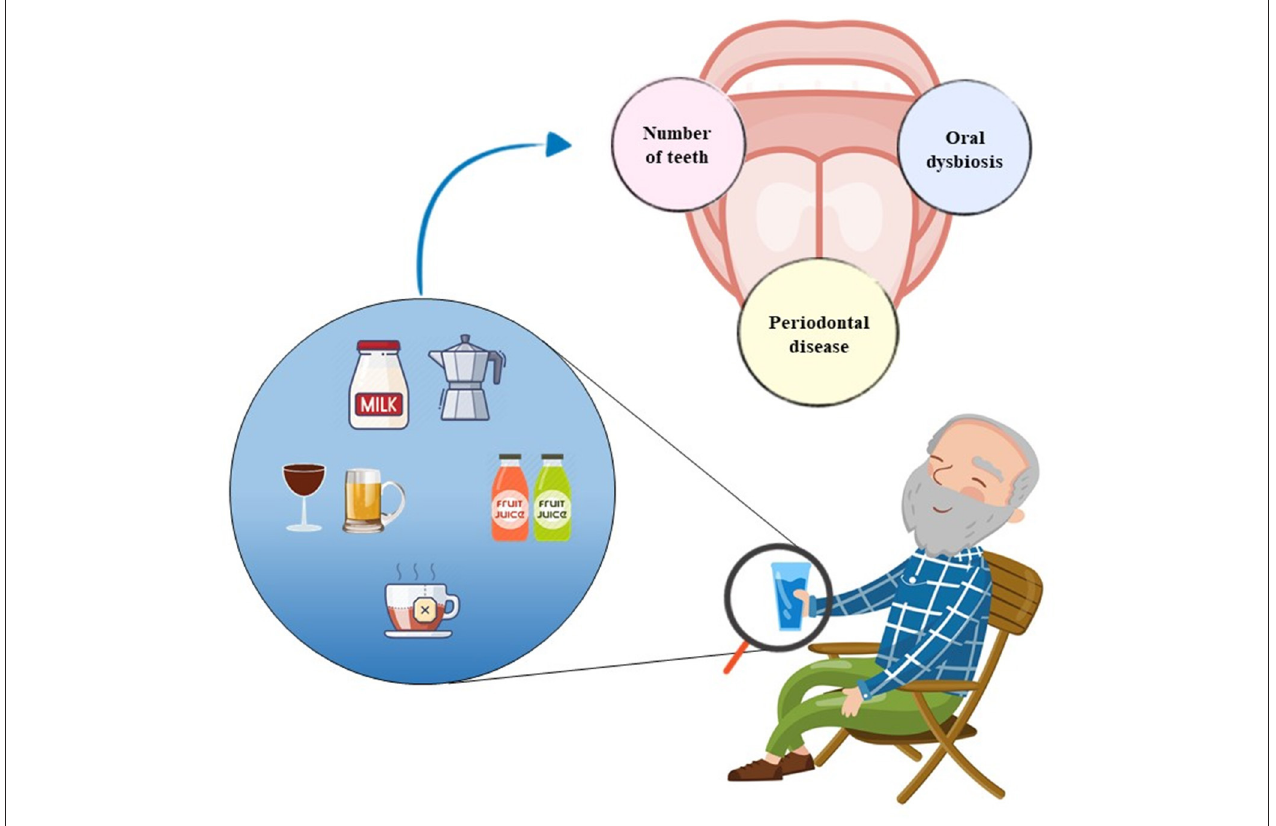
FIGURE 2 | Graphic overview of the